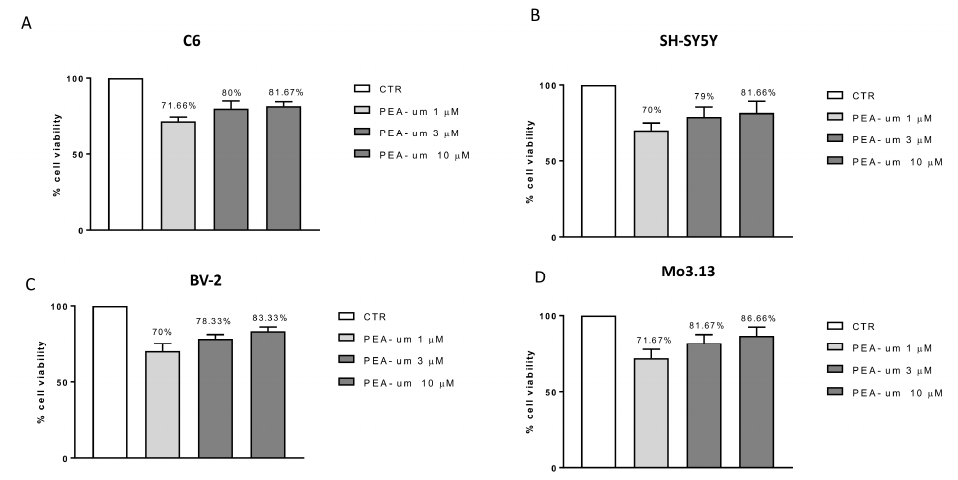
Figure 1. Cell viability evaluation after palmitoylethanolamide (PEA)-um treatment. Cell viability was evaluated using 3-(4,5-dimethylthiazol-2-yl)-2,5-diphenyl tetrazolium bromide (MTT) assay 24 h after treatment with PEA-um (1, 3, and 10 μ M) in four cell lines: neuronal SH-SY5Y ( B ), non-neuronal C6 ( A ), BV-2 ( C ), and Mo3.13 ( D ) cells. None of the PEA-um concentrations resulted in a significant cell mortality. Data are representative of at least three independent experiments.